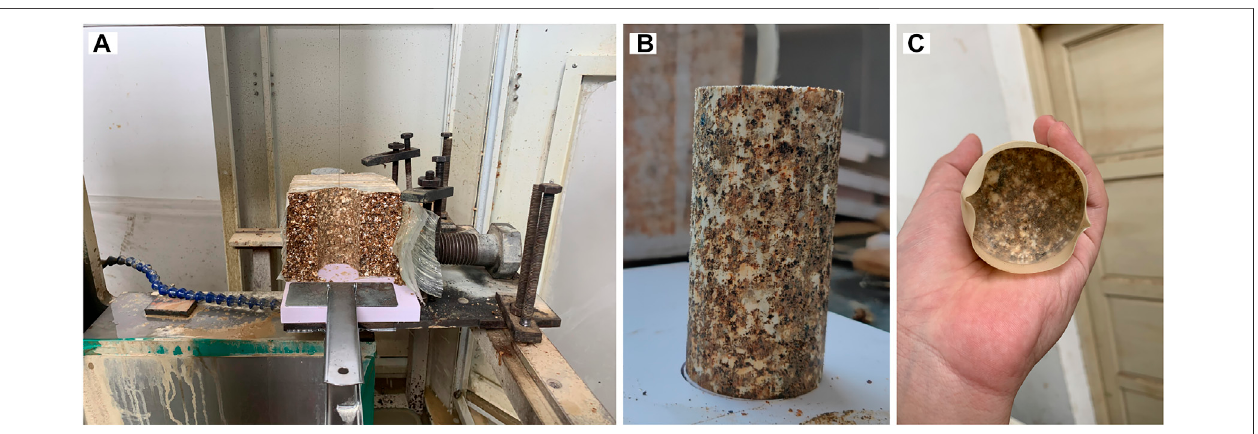
FIGURE 5| Weathered granite samplesprocessed by CNC abrasive wire sawingmachine: (A) Circular CNC abrasive wire sawing machine; (B) Prepared sample; (C) Packaged sample.